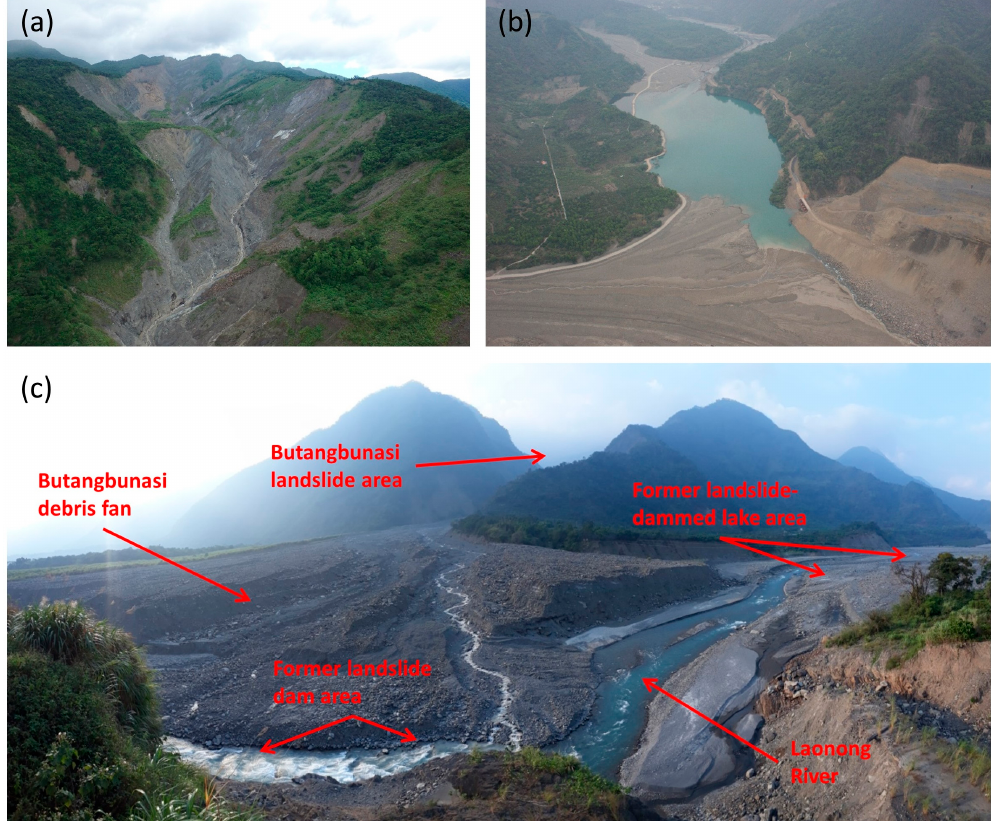
Figure 2. The Butangbunasi landslide area. ( a ) Unmanned aerial vehicle (UAV) image of the upper part of the Butangbunasi landslide. The image was taken on 13 June 2017. ( b ) UAV image of the temporary landslide-dammed lake at Butangbunasi and parts of the debris fan. The image was acquired on 29 April 2011. ( c ) Photograph of the Butangbunasi landslide from 15 November 2018. The photograph was taken from the Laonong river valley looking towards Butangbunasi; the actual landslide area is further up the tributary. The Butangbunasi debris fan, the former lake area, and the former landslide-dam area are indicated.